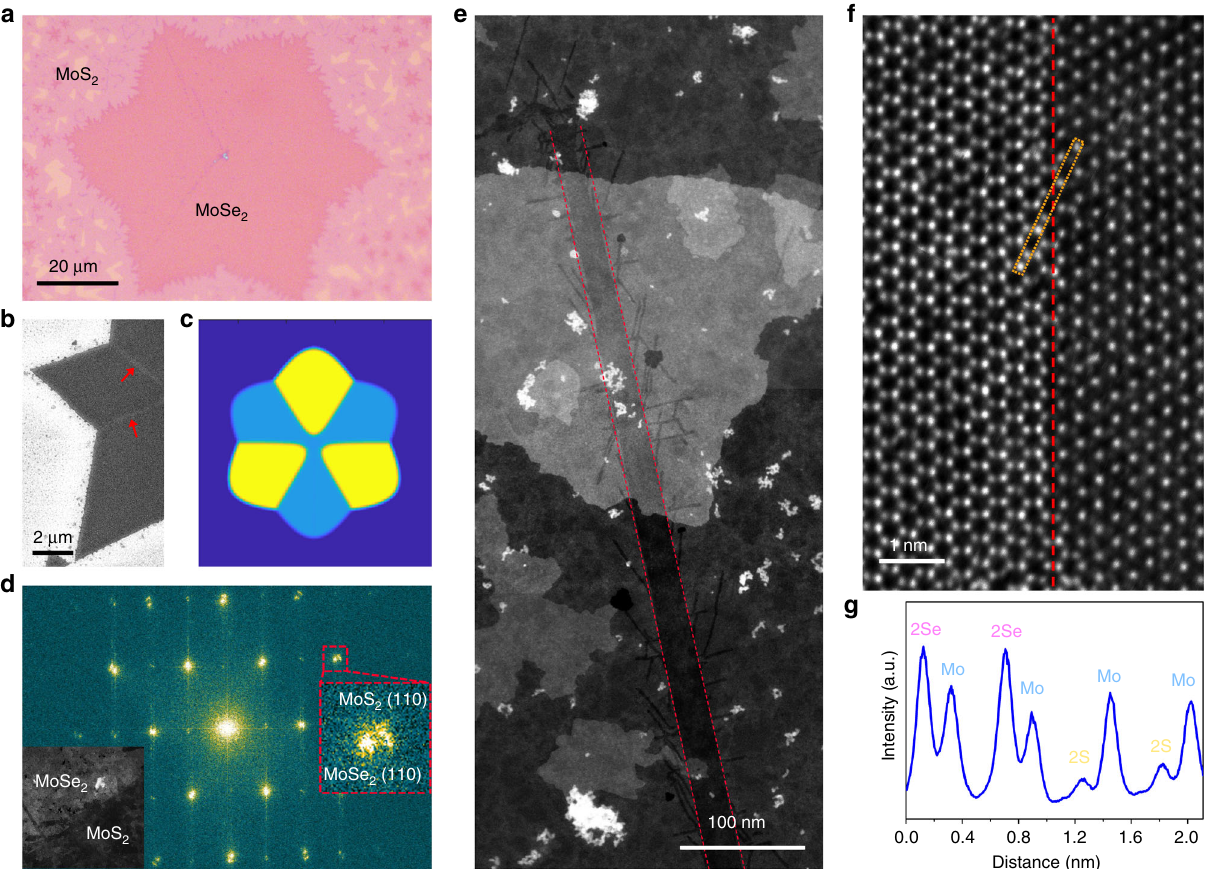
Fig. 2 Straight MoS 2 channels embedded in MoSe 2 matrix. a Optical image of the MoS 2 – MoSe 2 lateral heterojunction, where monolayer MoS 2 surrounds the six-piont star MoSe 2 . b SEM image showing the location of nano-channels (noted by the arrows). c Phase- fi eld simulation for the growth of six-point star MoSe 2 . d Fast Fourier transformation of the heterojunction region of the inserted ADF-STEM image. e Low-magni fi cation ADF-STEM image showing a straight MoS 2 channel of >600 nm inside single-layer MoSe 2 . Some brighter patches are out-of-plane MoSe 2 introduced during the transfer process. f ADF-STEM image of interface between MoS 2 channel and MoSe 2 matrix. The red dashed line denotes their straight and sharp interface along the zigzag direction. g Line intensity pro fi le of the rectangular region in f